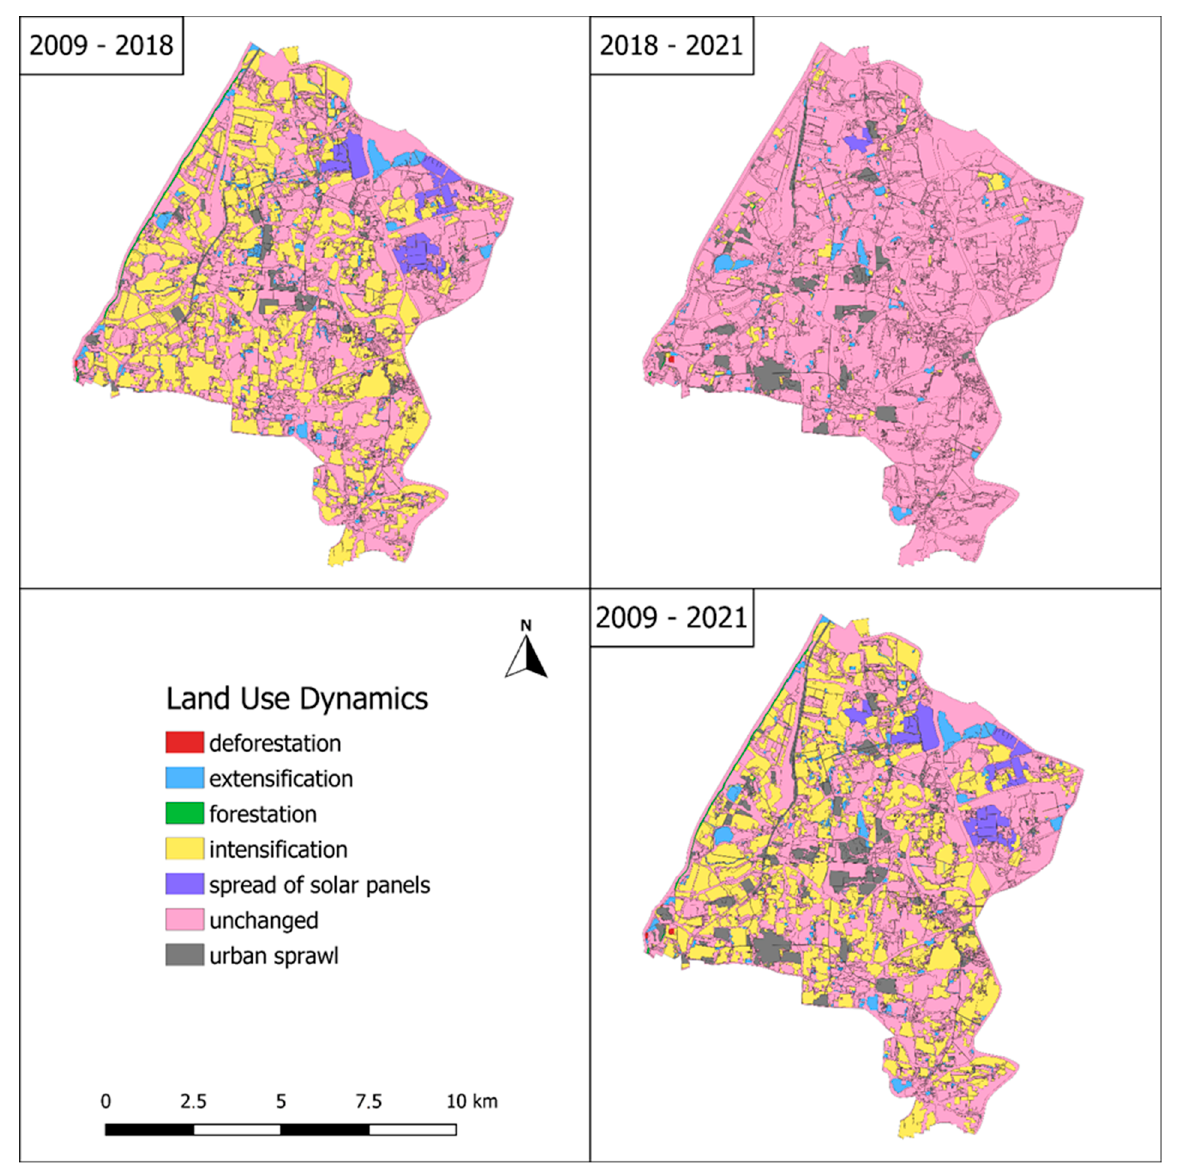
Figure 5. Maps of the land use changes.